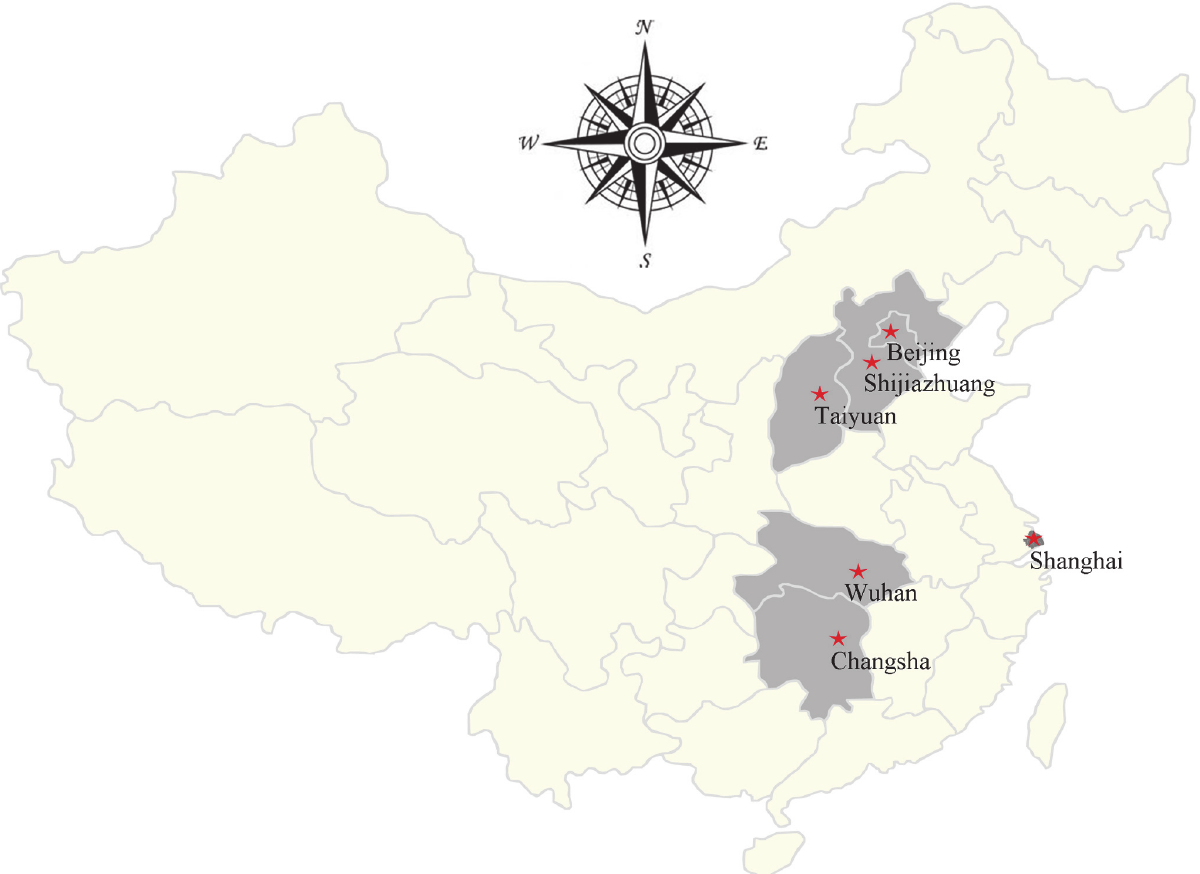
Fig 1. Specific locations at which specimens were collected in this study. ★ locations of